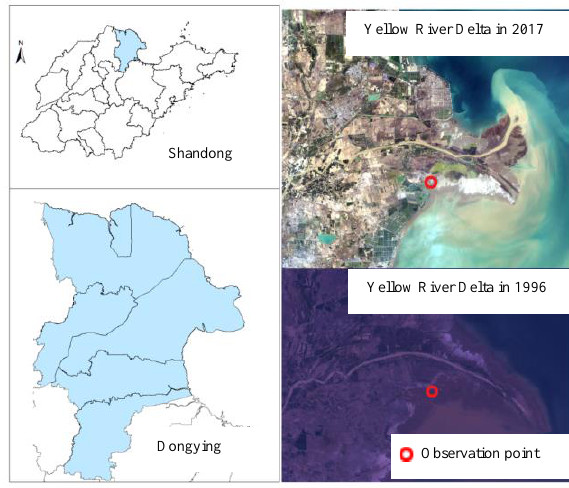
Figure 1 Location of the study area and observation point location on remote sensing imagery